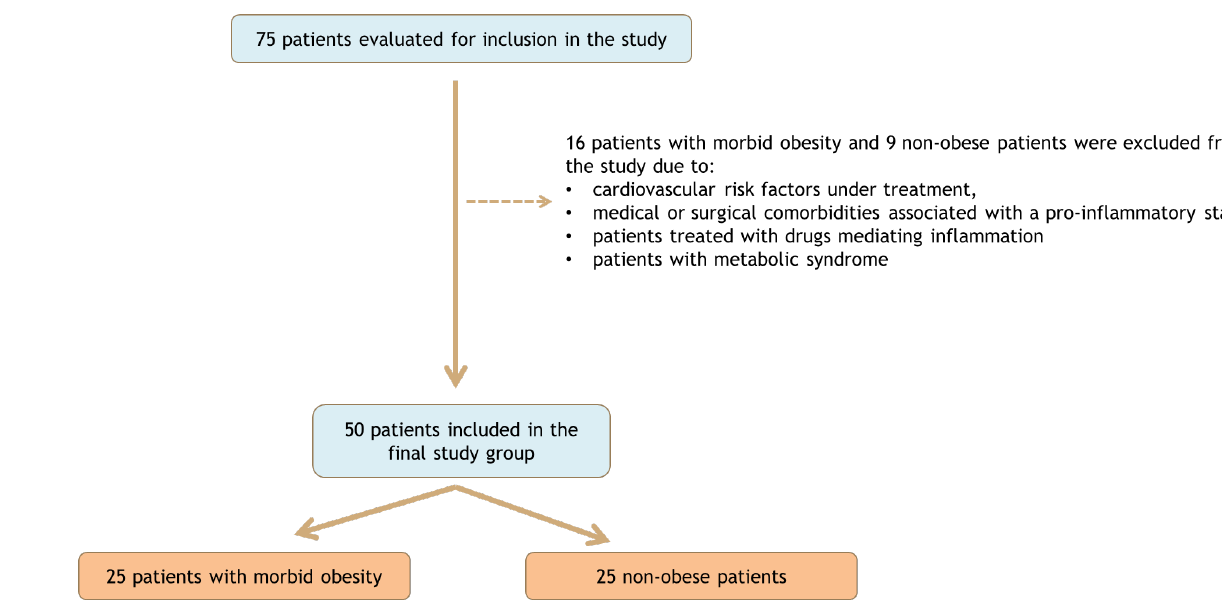
Figure 1. Flow chart of the studied group.